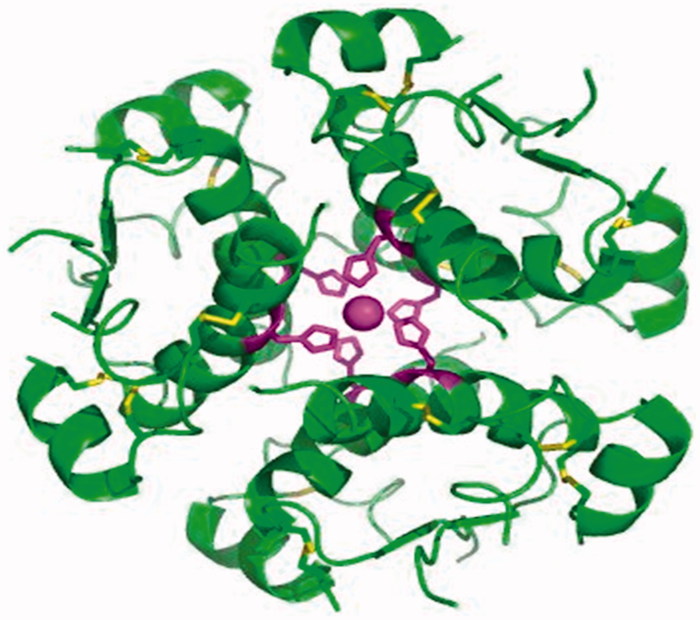
The protein structure of insulin20–22.